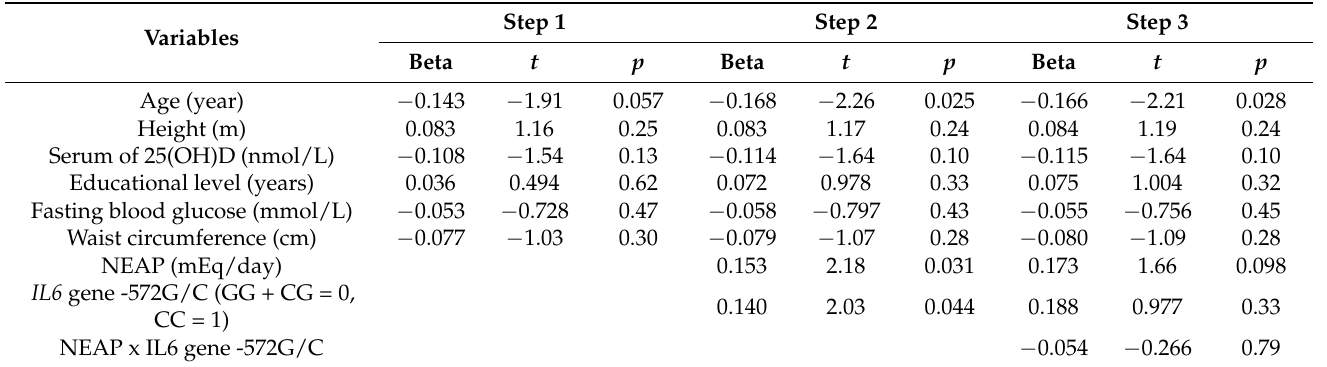
Table 4. Hierarchical linear regression analyses for the association between the selected variables and CTX1.